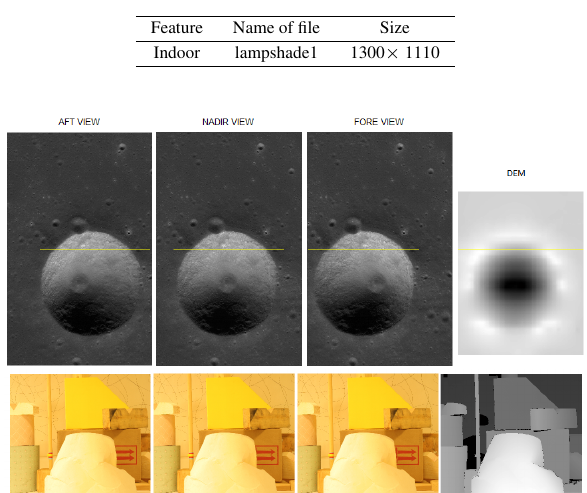
Figure 3: Input A-N-F view triplet images for Marius D crater and DEM, yellow line shows the scan line for which experiment is performed whose results are shown in figure 4 are obtained for epipolar resampling. Using these parameters Aft (and Fore) to are resampled to follow epiploar geometry w.r.t. Nadir.